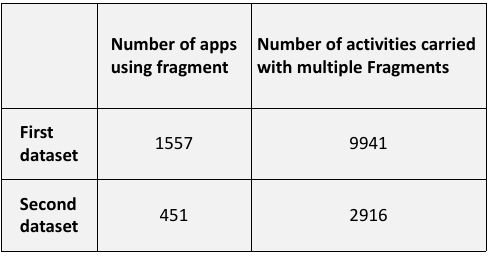
Figure 11. Distribution of source-sink